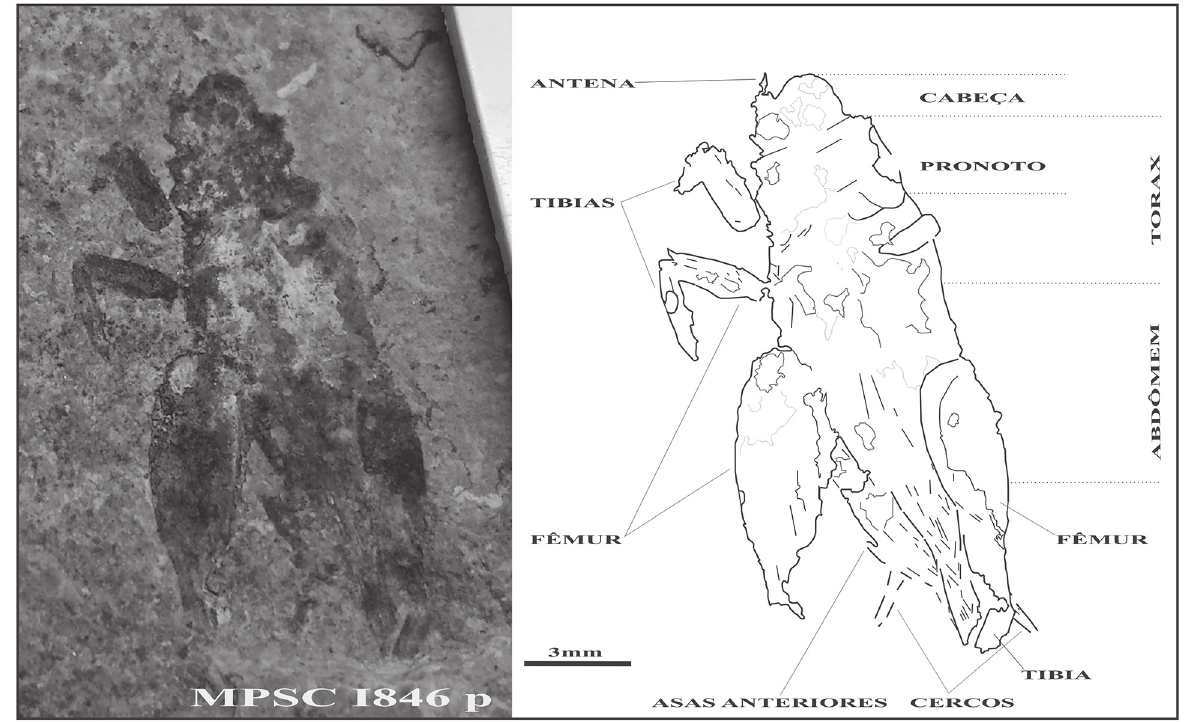
Figure 3 - Araripegryllus romualdoi sp. nov. (MPSC 1846p) on the left, and its schematic drawing on the